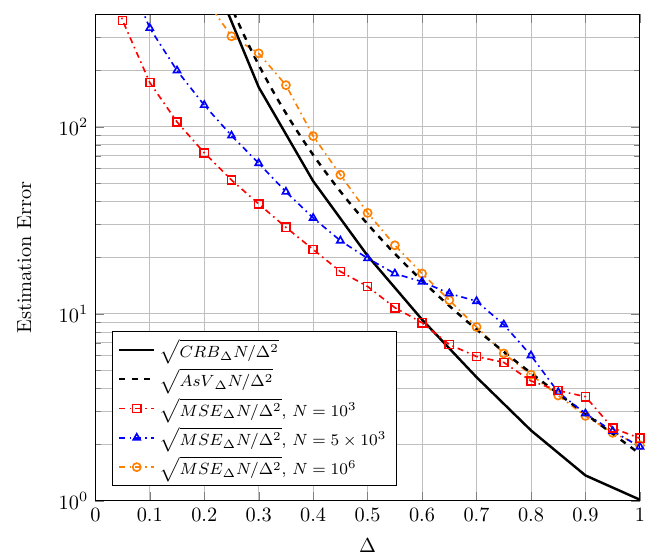
Figure 6. Sqrt-normalized MSE ∆ for the estimation of ∆ using Equation (16) for K = 3 and different number of observations N . Also shown are the corresponding sqrt-normalized AsV ∆ and sqrt-normalized CRB ∆ .